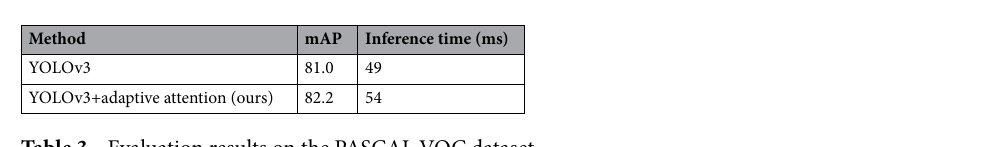
Table 3. Evaluation results on the PASCAL VOC